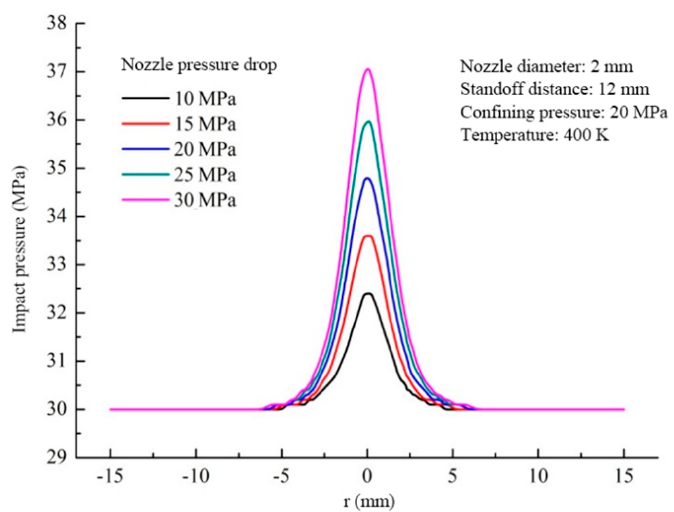
Figure 8. Influence of the nozzle’s pressure drop on impact pressure.